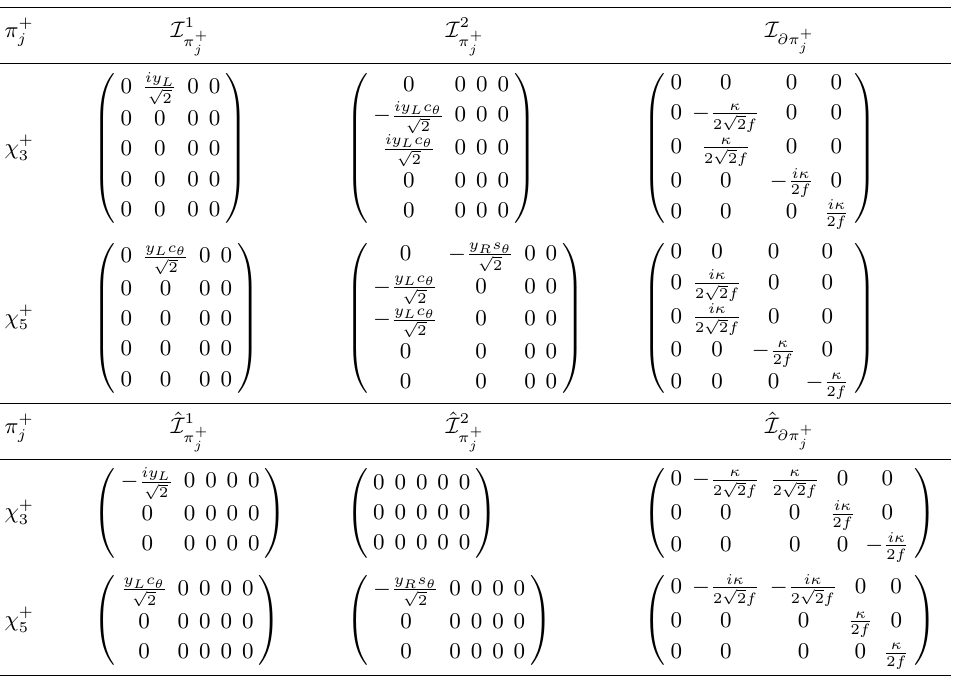
Table 7 . The expressions for the couplings to the charged pNGBs, I 1 , 2 π + ≡ χ + , χ + . 3 5 j